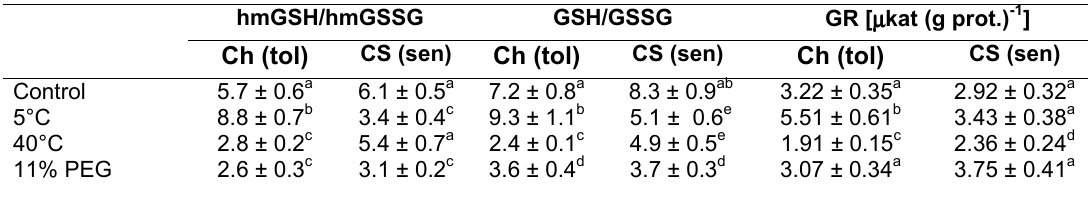
Effect of Abiotic Stresses on the Ratio of Reduced to Oxidised Hydroxymethylglutathione and Glutathione and on Glutathione Reductase Activity in Shoots of a Frost-Tolerant Wheat Variety, Cheyenne (Ch), and a Frost-Sensitive Chinese Spring